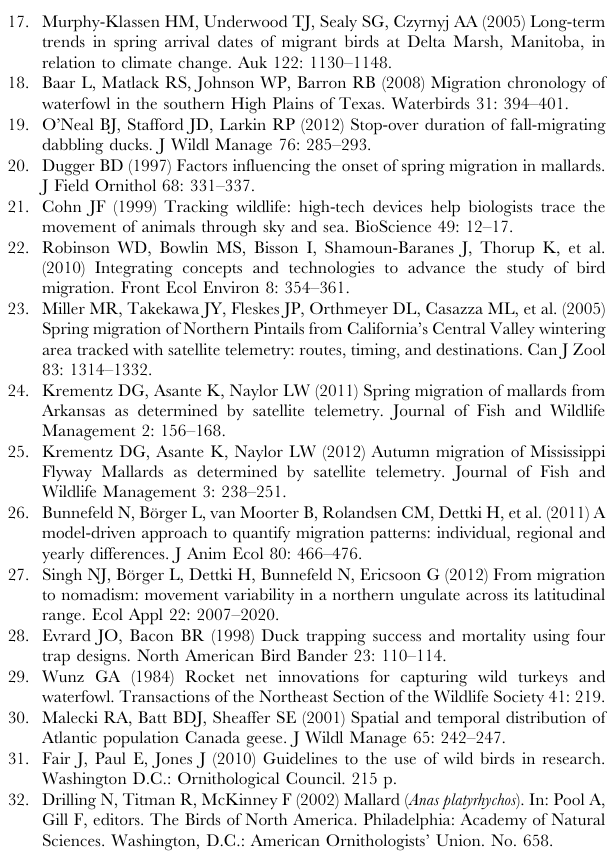
Table S1 Variables and statistical tests for analysis of variance models that examined migration chronology,